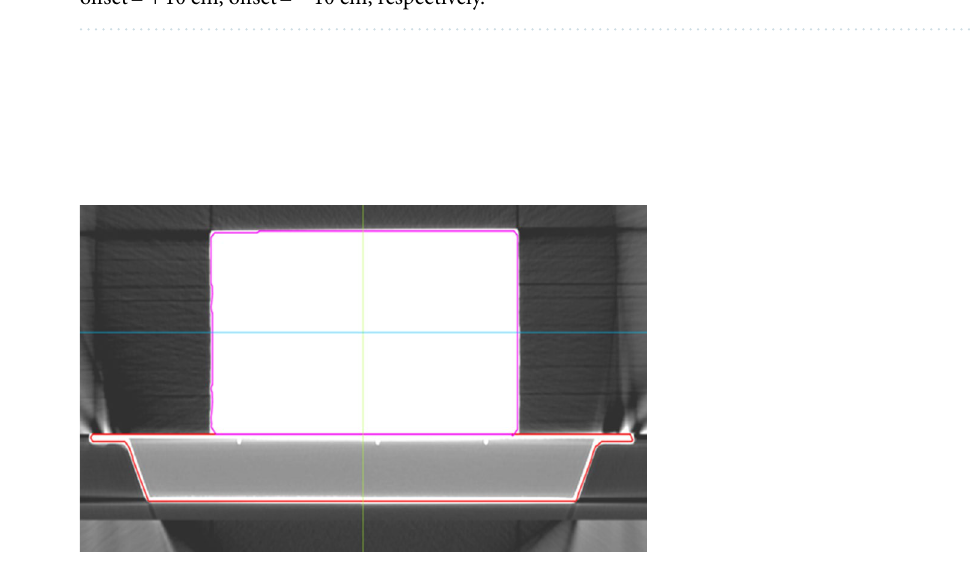
Figure 3. The structures of the carbon fiber couch and phantom dataset that was scanned by the diagnostic CT scanner integrated with the